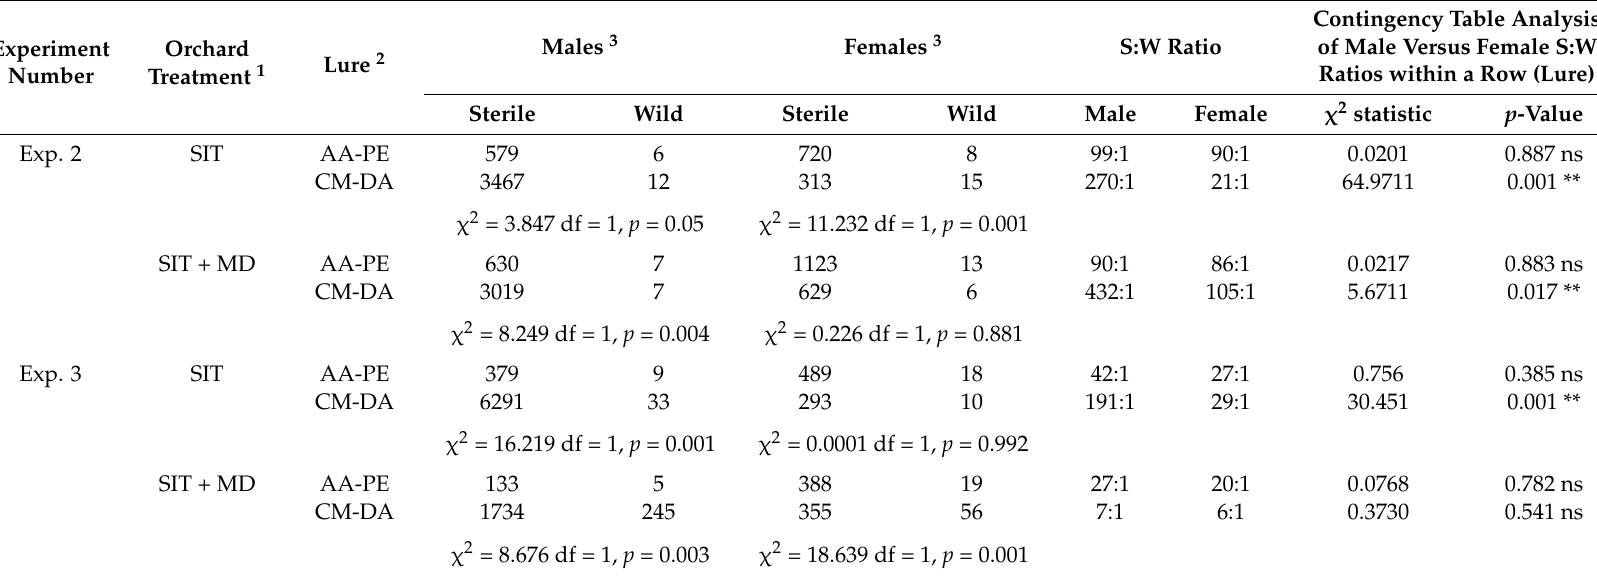
Contingency Table Analysis of Male Versus Female S:W Ratios within a Row (Lure)